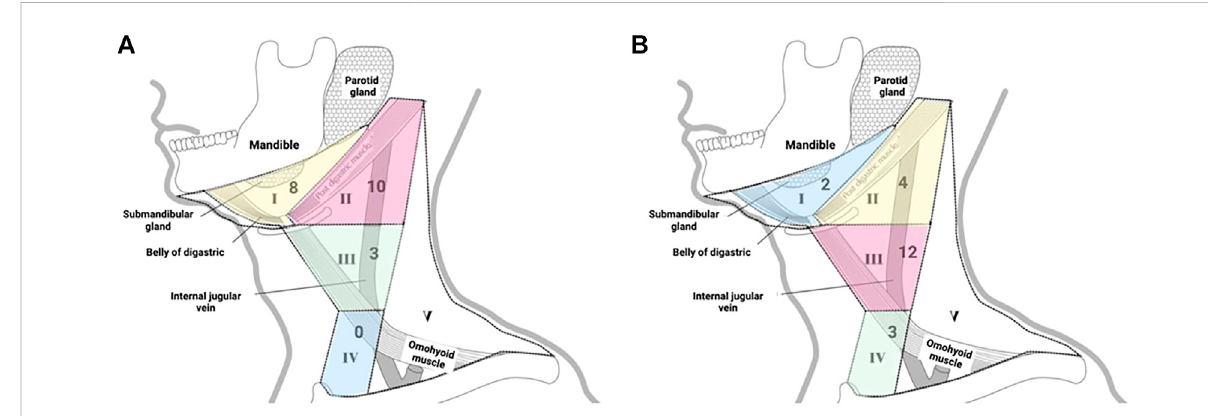
FIGURE 2 (A) Distributionofthe fi rstdrainingNIR fl uorescentLNintonguecarcinomapatients; (B) Distribution ofthemetastaticLNsintonguecarcinoma patients.